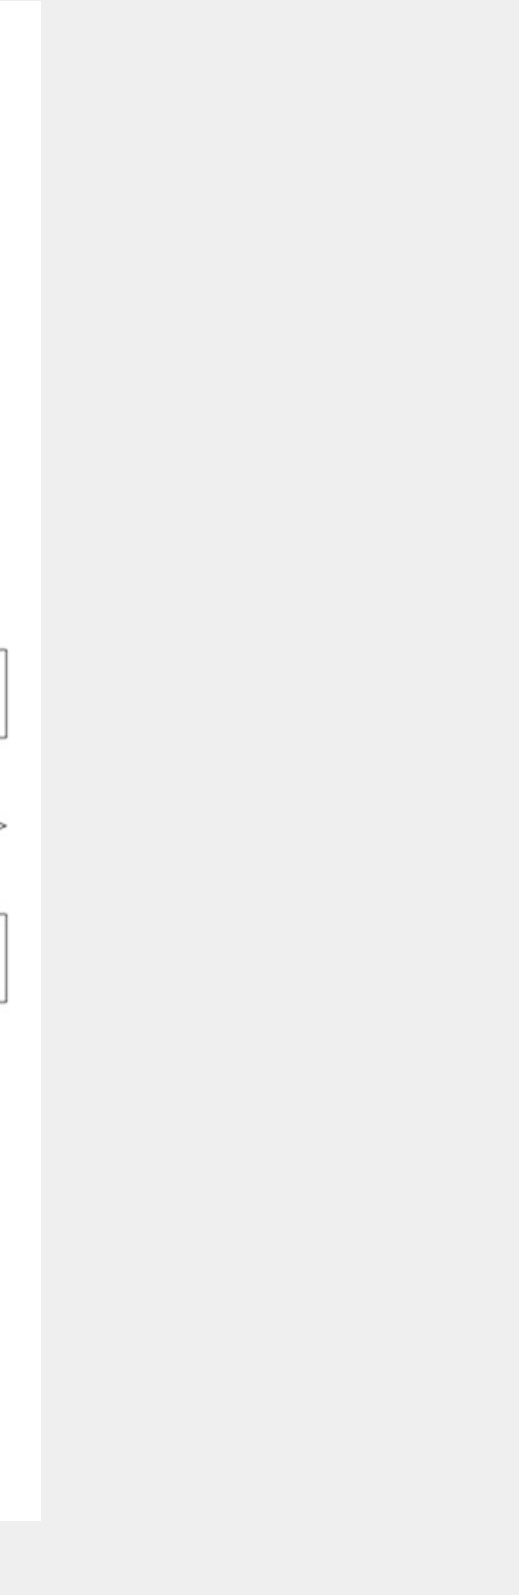
Heart allocation algorithm as implemented in the SOAS. D = donor; MT = multi-organ transplantation; R =